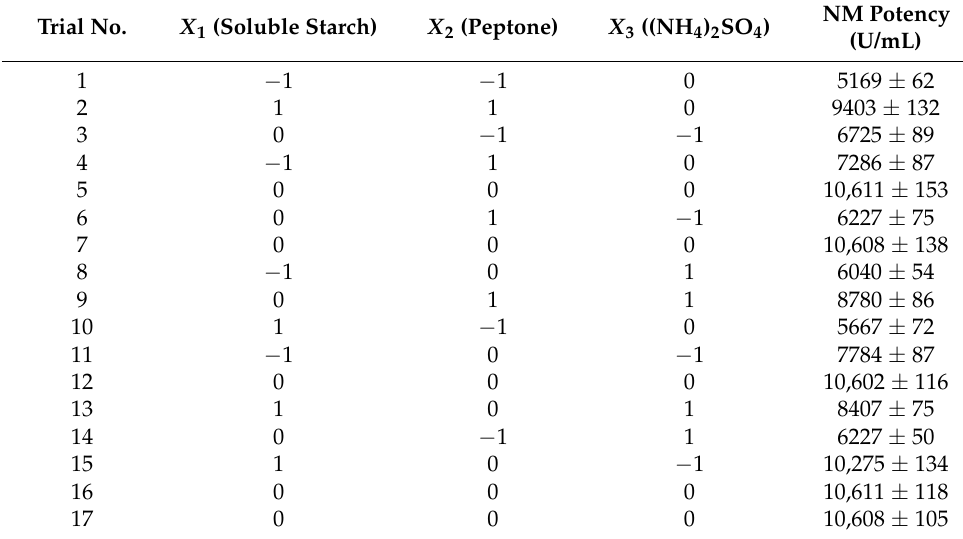
Table 6. Response surface method (RSM) arrangements and results. Trial No. X 1 (Soluble Starch)